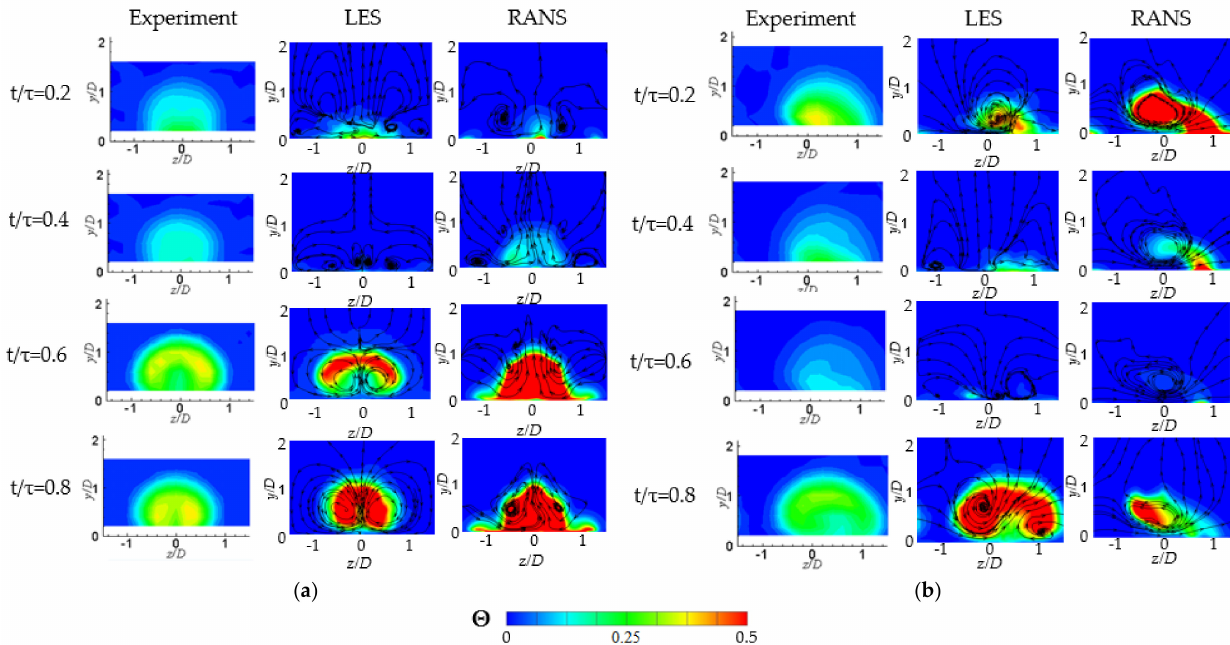
Figure 10. Phase-averaged dimensionless temperature contours and streamlines for the orientation angle of 0 ◦ and 30 ◦ on the plane of x/D = 2.5, 5, and 10 for the flow pulsation of 36 Hz. ( a ) Simple angle ( β = 0 ◦ ); ( b ) Compound angle, β =